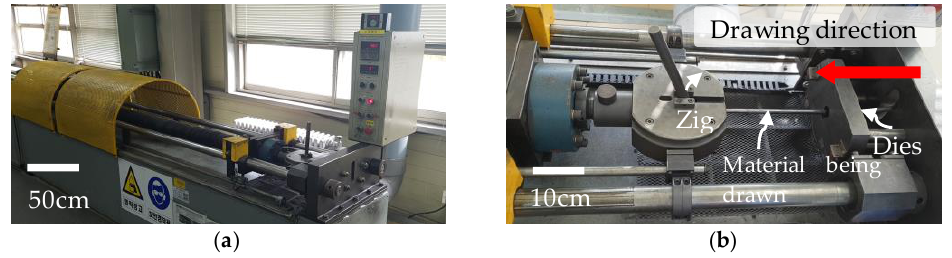
Figure 1. ( a ) Overall view of the draw bench equipment and control box. Maximum load is 20 tons and maximum drawing speed is 1 m/min. ( b ) Material being drawn, dies and a zig.